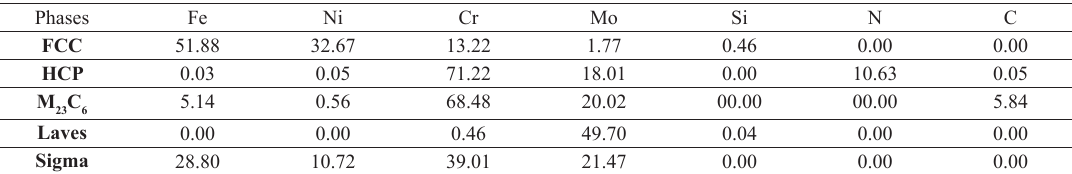
Table 4. Possible chemical composition (% weight) of the equilibrium phases in AL-6XN PLUS at 600 ºC, obtained with Thermocalc®. Phases